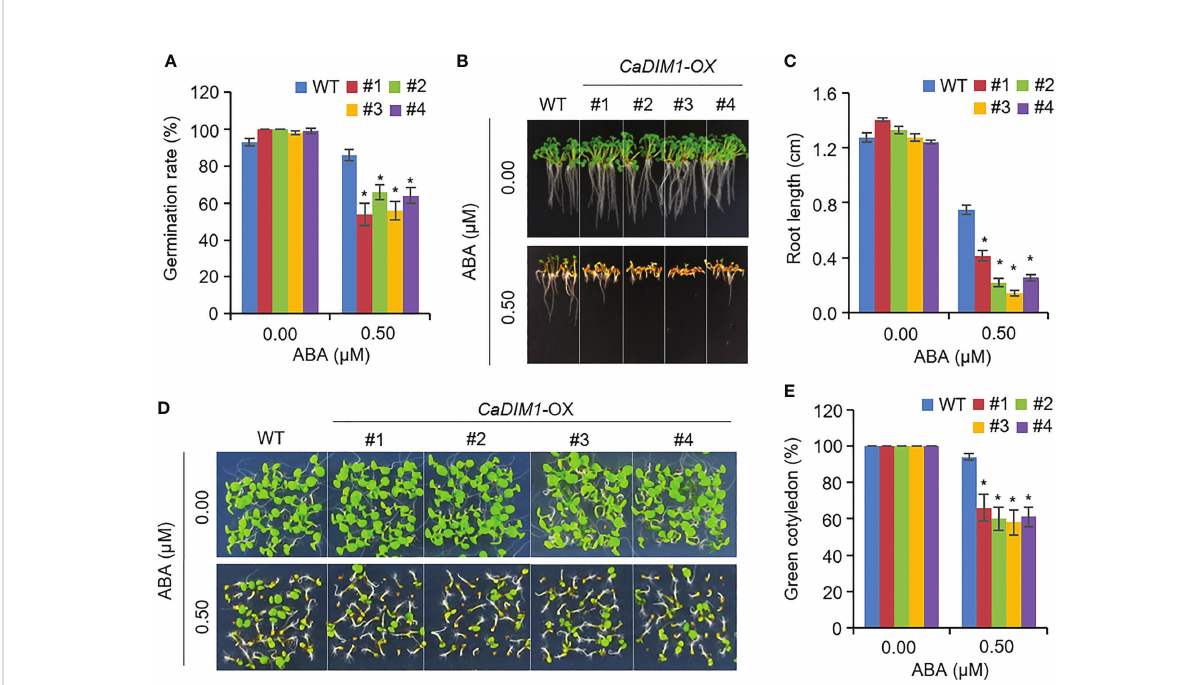
FIGURE 6 Increased sensitivity of CaDIM1 -overexpressing (OX) transgenic Arabidopsis plants to ABA during germination and seedling growth. (A) Seed germination of wild-type (WT) and transgenic lines in response to ABA. Seeds were germinated on 0.5x Murashige and Skoog (MS) agar plates containing 0.0 m M and 0.5 m M of ABA. (B, C) Root elongation of wild-type and transgenic plants in response to 0.0 m M and 0.75 m M ABA. The representative images were taken (B) and the root length of each plant was measured 6 days after plating (C) . Data represent the mean ± standard error of three independent experiments. (D, E) Growth of wild-type and transgenic line seedlings on 0.5x MS agar plates containing 0.0 m M and 0.5 m M ABA. Representative images were taken (D) and quanti fi cation of green cotyledons was conducted 7 days after plating (E) . Data represent the mean ± standard error of four independent experiments; in each of these experiments, 36 seeds were evaluated. Asterisks indicate signi fi cant differences between wild-type and CaDIM1- OX plants (Student ’ s t -test; * P <